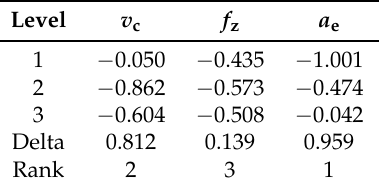
Table 16. Average S/N ratios for ball end milled horizontal